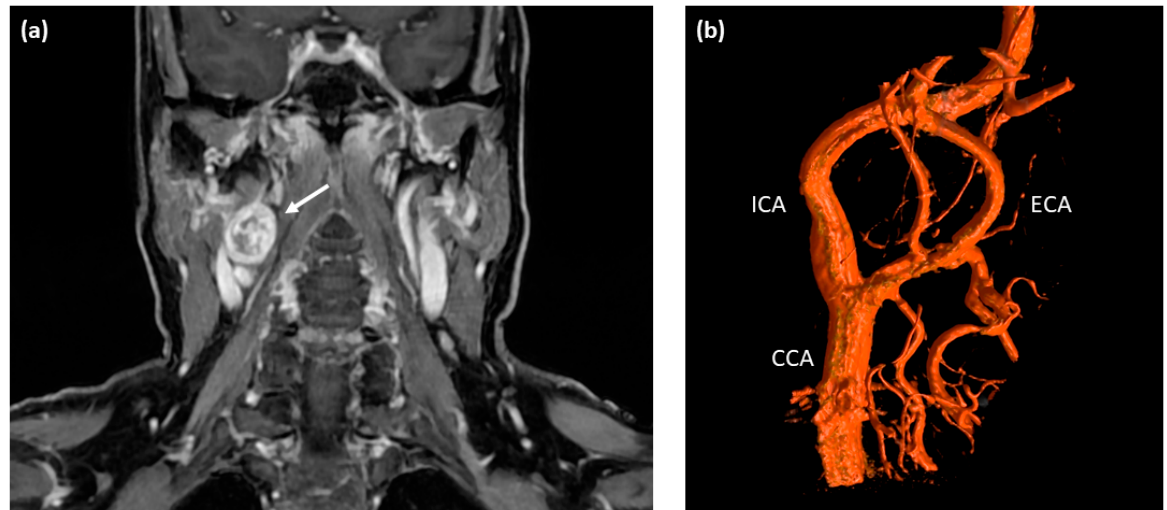
Figure 1. Pre-operative imaging of the right-sided cervical mass. ( a ) T1-weighted contrast-enhanced MRI scan of the neck depicting a round-shaped tumor located at the level of carotid bifurcation with irregular contrast enhancement (white arrow). ( b ) Digital subtraction angiography (DSA) showing a splaying of the internal and external carotid artery around the cervical mass located at the level of the carotid bifurcation; no major feeding vessels were detected making this tumor unsuitable for embolization. ICA—internal carotid artery; ECA—external carotid artery; CCA—common carotid artery.